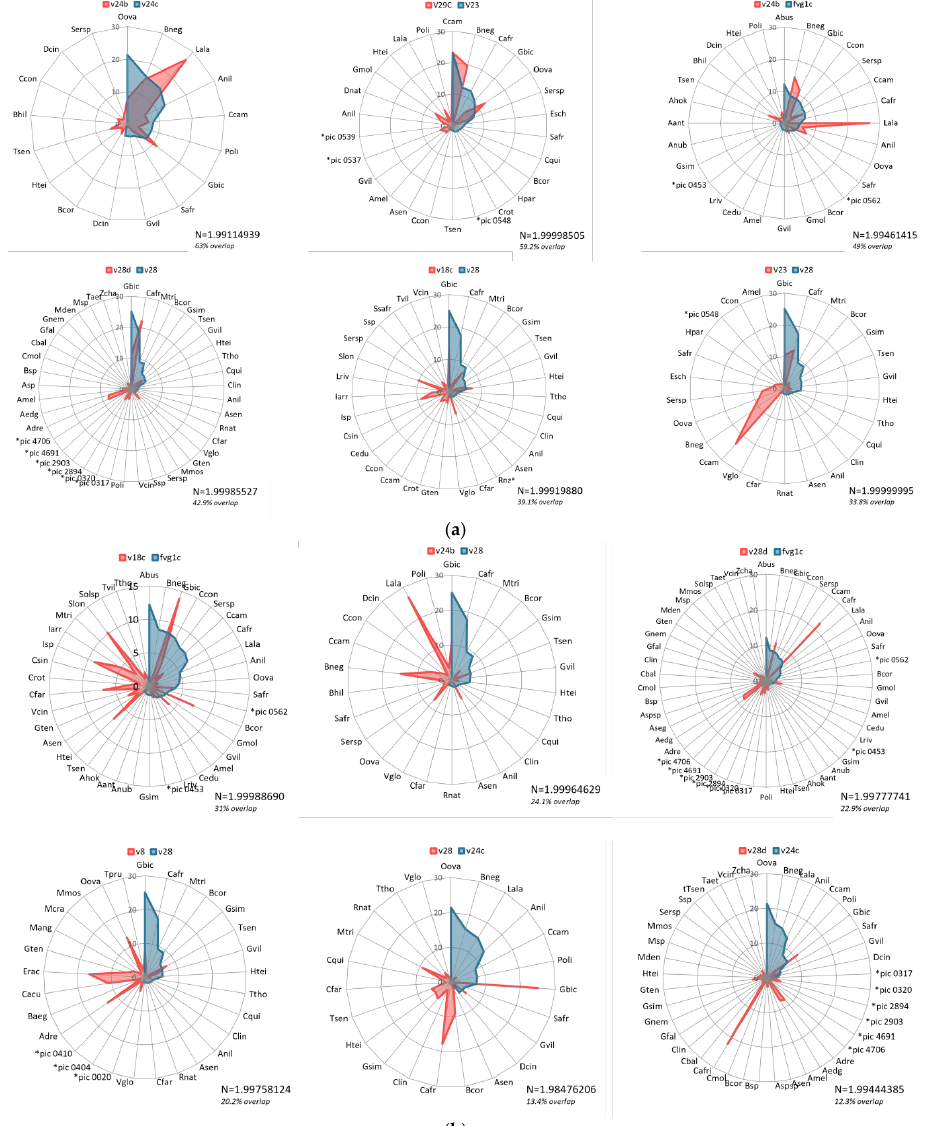
Figure 11. ( a ) Paired comparisons of vegetation species’ compositions for classification classes that returned an ROI separability metric between N = 1.98 and N = 1.9999 in order from the highest species overlap. There are very high percentage overlaps in the first two graphs, over 50%. They also show the presence of vegetation species that are unique to either of the class communities. The second graph shows a common dominant species between the two vegetation communities, but that varies in the rest of the graphs. The ranking of species overlap does not directly match with the ranking of the ROI separability values. See Appendix A Table A1 for abbreviated species’ names meaning. Unknown species were assigned labels starting with *pic and are shown in Figure A1. ( b ) A continuation of Figure 11a, where we can observe an increase in species that are unique to either of the class pairs. Interestingly, the graph second from last of this series is the lowest in ROI separability value but has quite distinct species occurring in either of the vegetation community pairs, and hence the ranking and value of ROI separability is not a direct indicator of the quantity of shared or common species occurring in both vegetation community pairings. See Appendix A Table A1 for abbreviated species’ names meaning. Unknown species were assigned labels starting with *pic and are shown in Figure